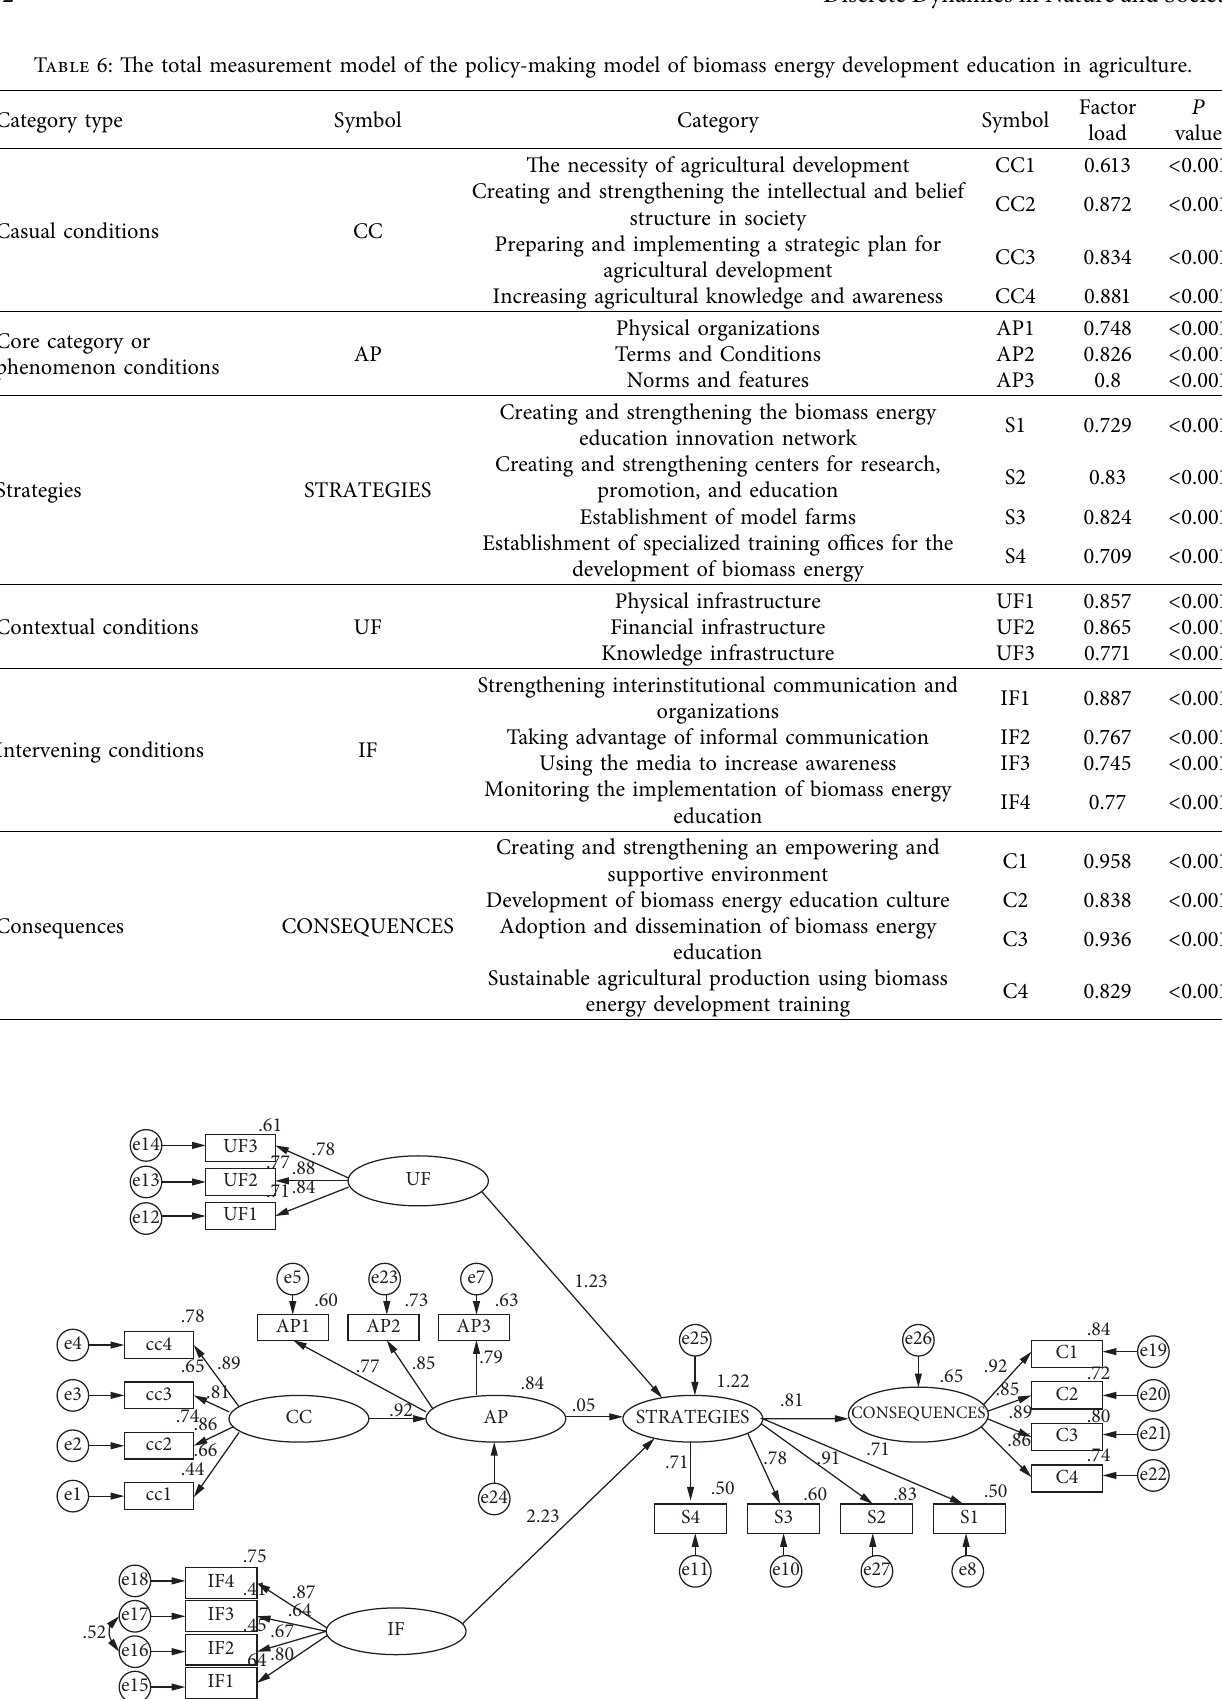
Figure 3: Structural model of the policy-making pattern related to biomass energy development training in agriculture.